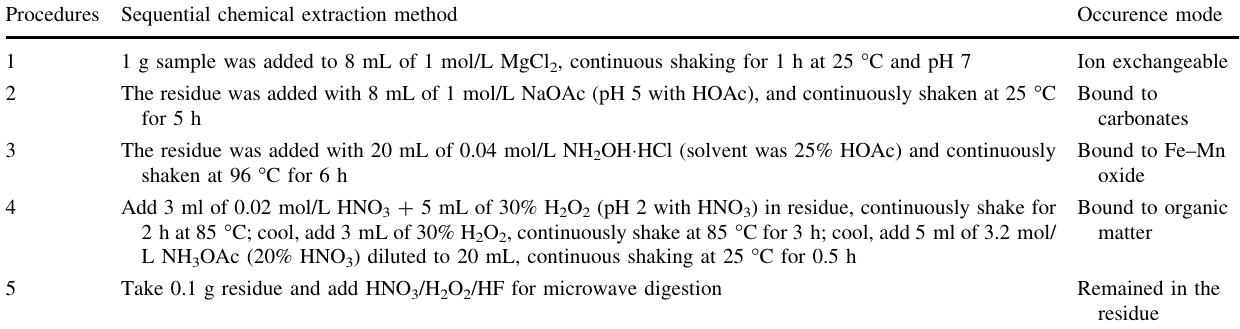
Table 2 Sequential chemical extraction procedure Procedures Sequential chemical extraction